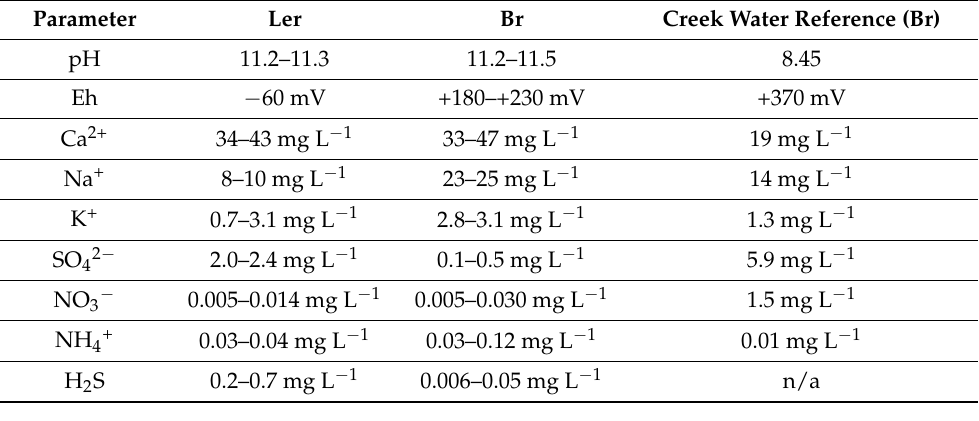
Table 1. Selected water chemistry parameters of the sampling sites (see Table S1 for a complete dataset from alkaline springs), Ler: Torrente Lerone samples; Br: Torrente Branega samples.